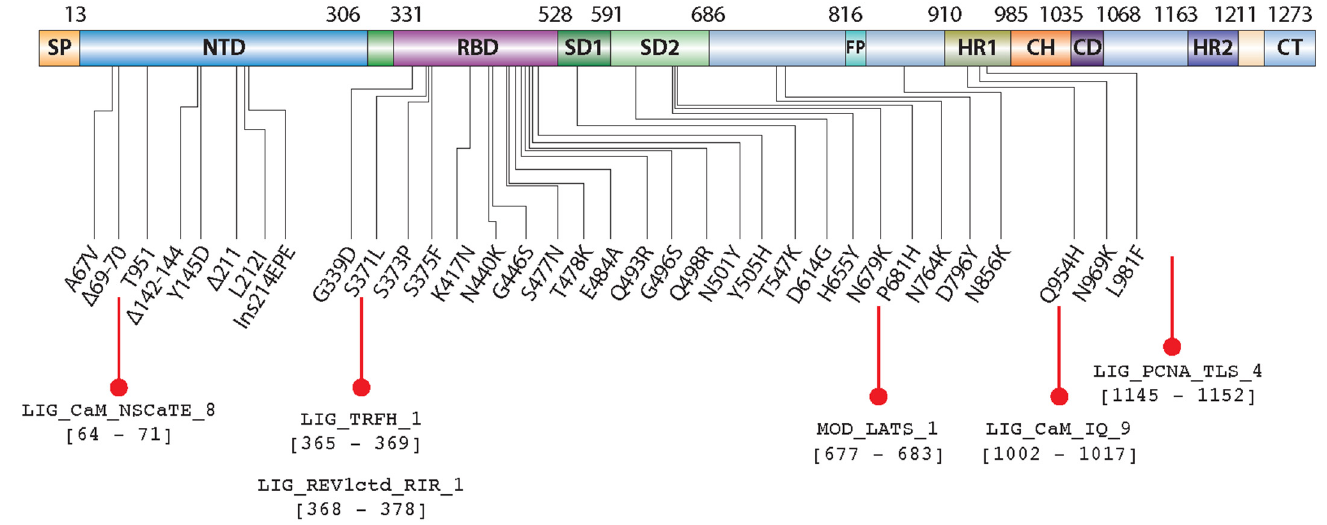
Figure 6. Schematic representation of Omicron spike protein organization and amino acid mutations. Omicron mutations are shown in a primary structure of SARS ‐ CoV ‐ 2 S ‐ protein. Amino acid mutations in SARS ‐ CoV ‐ 2 Omicron spike proteins are A67V, Del69 ‐ 70, T95I, Del142 ‐ 144, Y145D, Del211, L212I, R214Insertion, G339D, S371L, S373P, S375F, K417N, N440K, G446S, S477N, T478K, E484A, Q493R, G496S, Q498R, N501Y, Y505H, T547K, D614G, H655Y, N679K, P681H, N764K, D796Y, N856K, Q954H, N969K, and L981F. Selected SLiMs introduced due to the mutation in Omicron variants are marked at the bottom of the domain map.